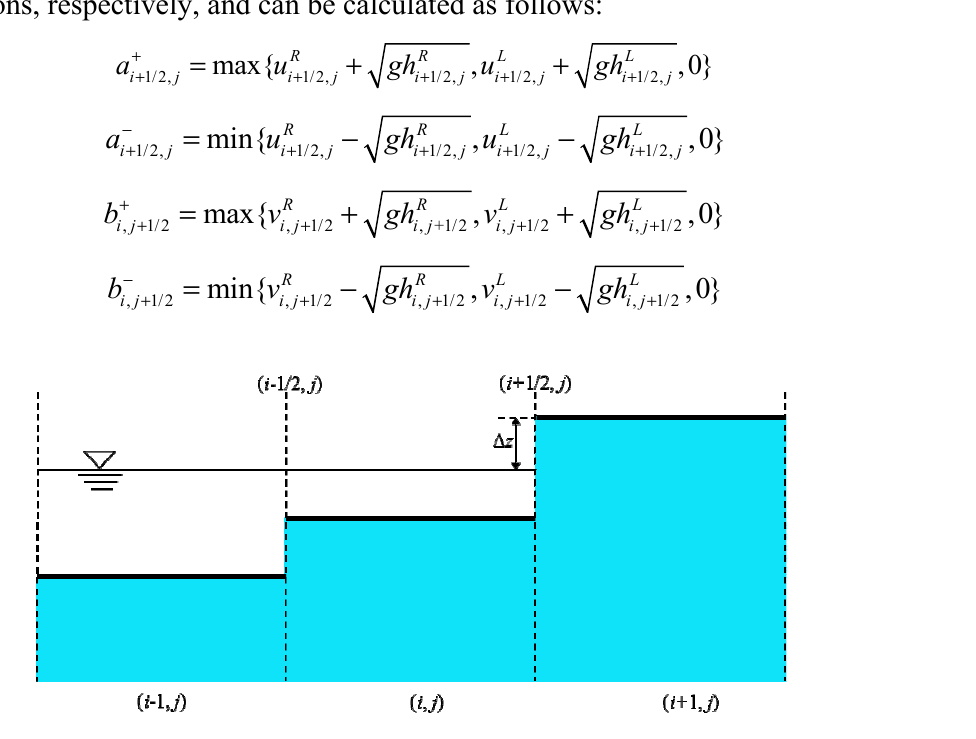
Figure 2. Local bed modification for dry-bed